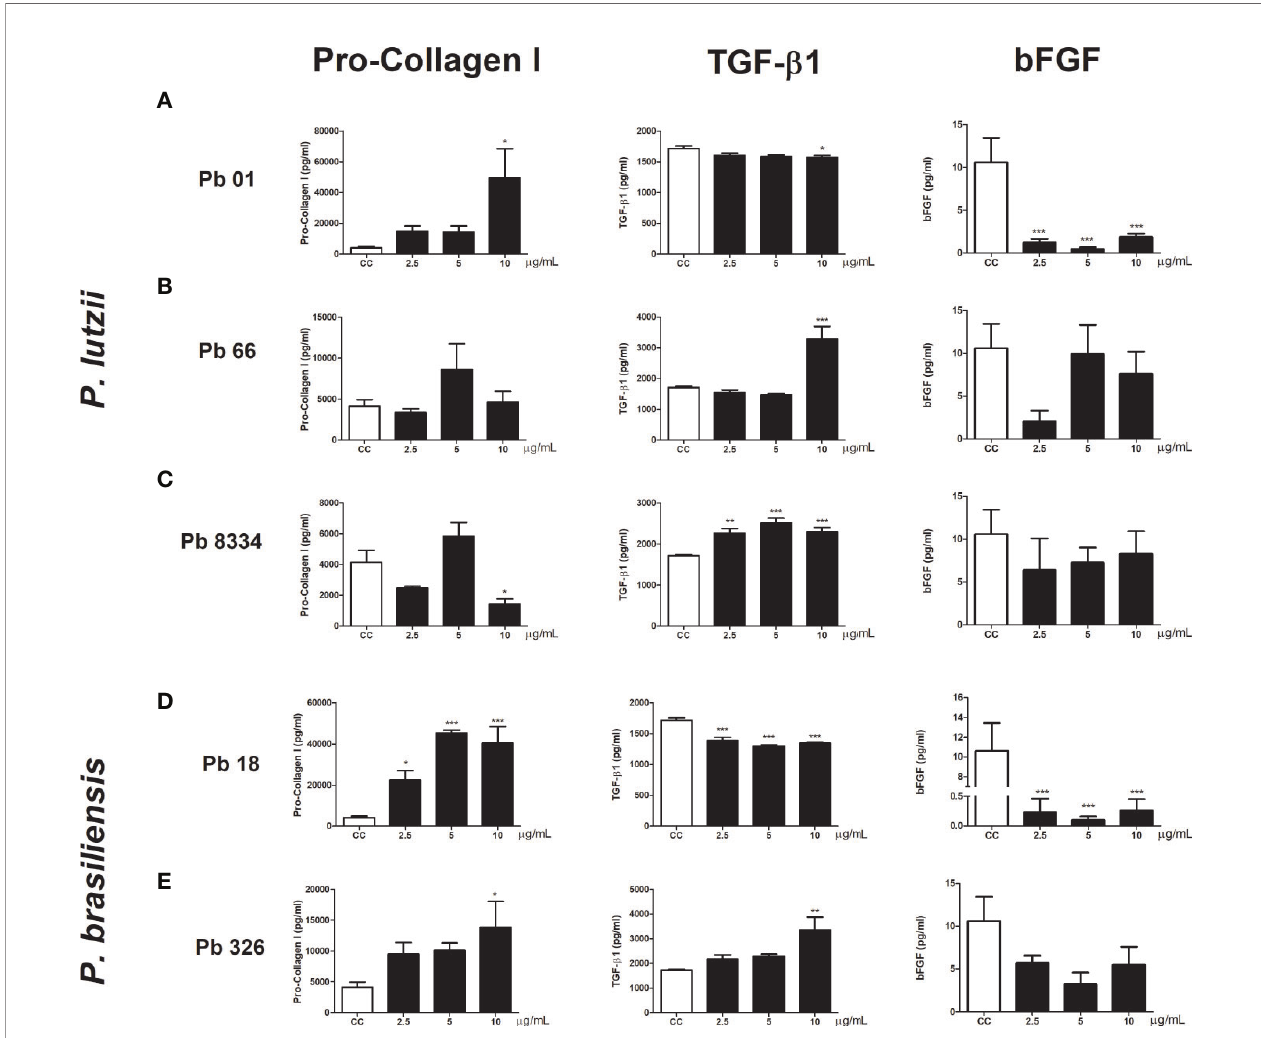
FIGURE 3 | Human pulmonary fi broblast activity stimulated by Paracoccidioides spp. exoantigens. Fibroblasts were cultured in the presence or absence of Paracoccidioides spp. exoantigens and levels of pro-collagen I, TGF- b 1, and bFGF in the cell-free supernatants were determined 24 h post-treatment. (A) Pb01 exoantigen. (B) Pb66 exoantigen. (C) Pb8334 exoantigen. (D) Pb18 exoantigen. (E) Pb326 exoantigen. Results are expressed as means ± SEM; ANOVA with Dunnett ’ s post hoc test; * p < 0.05, ** p < 0.01, *** p < 0.001; n =